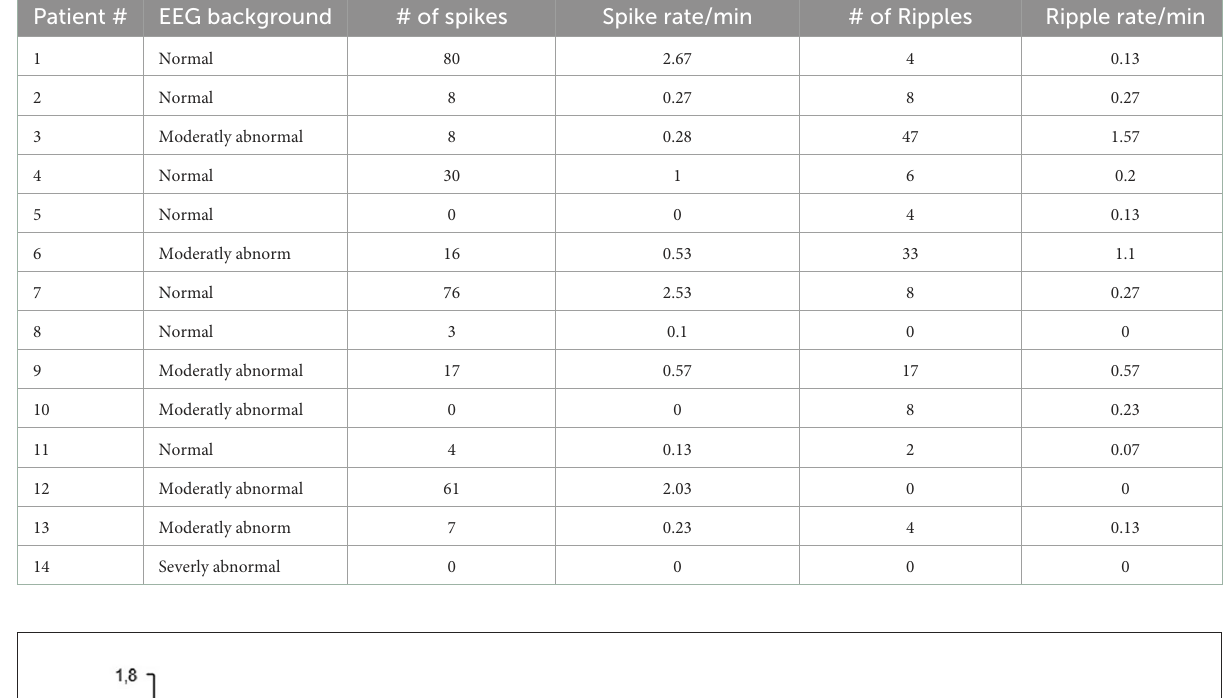
TABLE 2 Details of EEG results. Rates are given as the length of analyzed EEG was variable due to